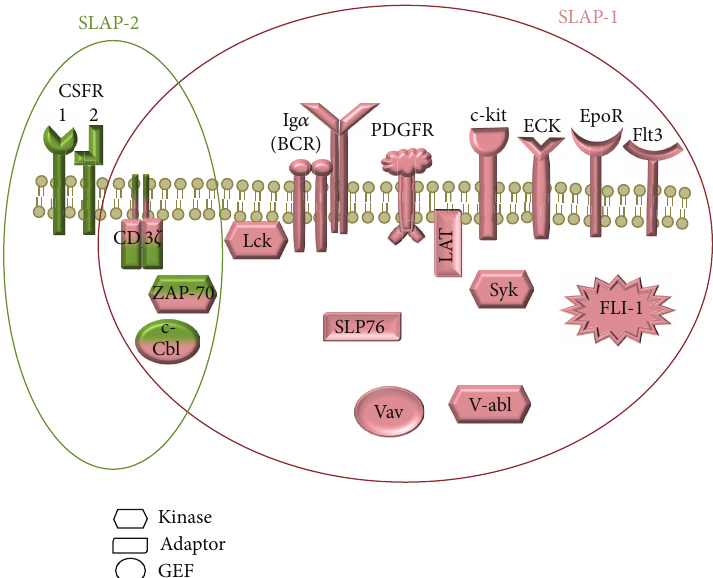
Figure 2: The interaction partners of SLAP-1 (pink) and SLAP-2 (green). Several proteins have been reported to interact with SLAP-1 molecule: c-Cbl, CD3 𝜁 chain, ECK, EpoR, Ig 𝛼 , LAT, Lck, PDGFR, SLP-76, Syk, v-abl, Vav (protooncogene vav), ZAP70, c-kit, Flt3,